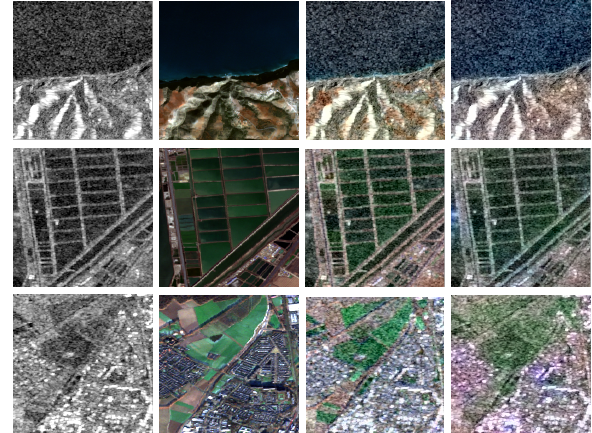
Figure 4. Some exemplary patch-pairs from the SEN1-2 dataset. Top row: Sentinel-1 SAR image patches, bottom row: Sentinel-2 RGB image patches.